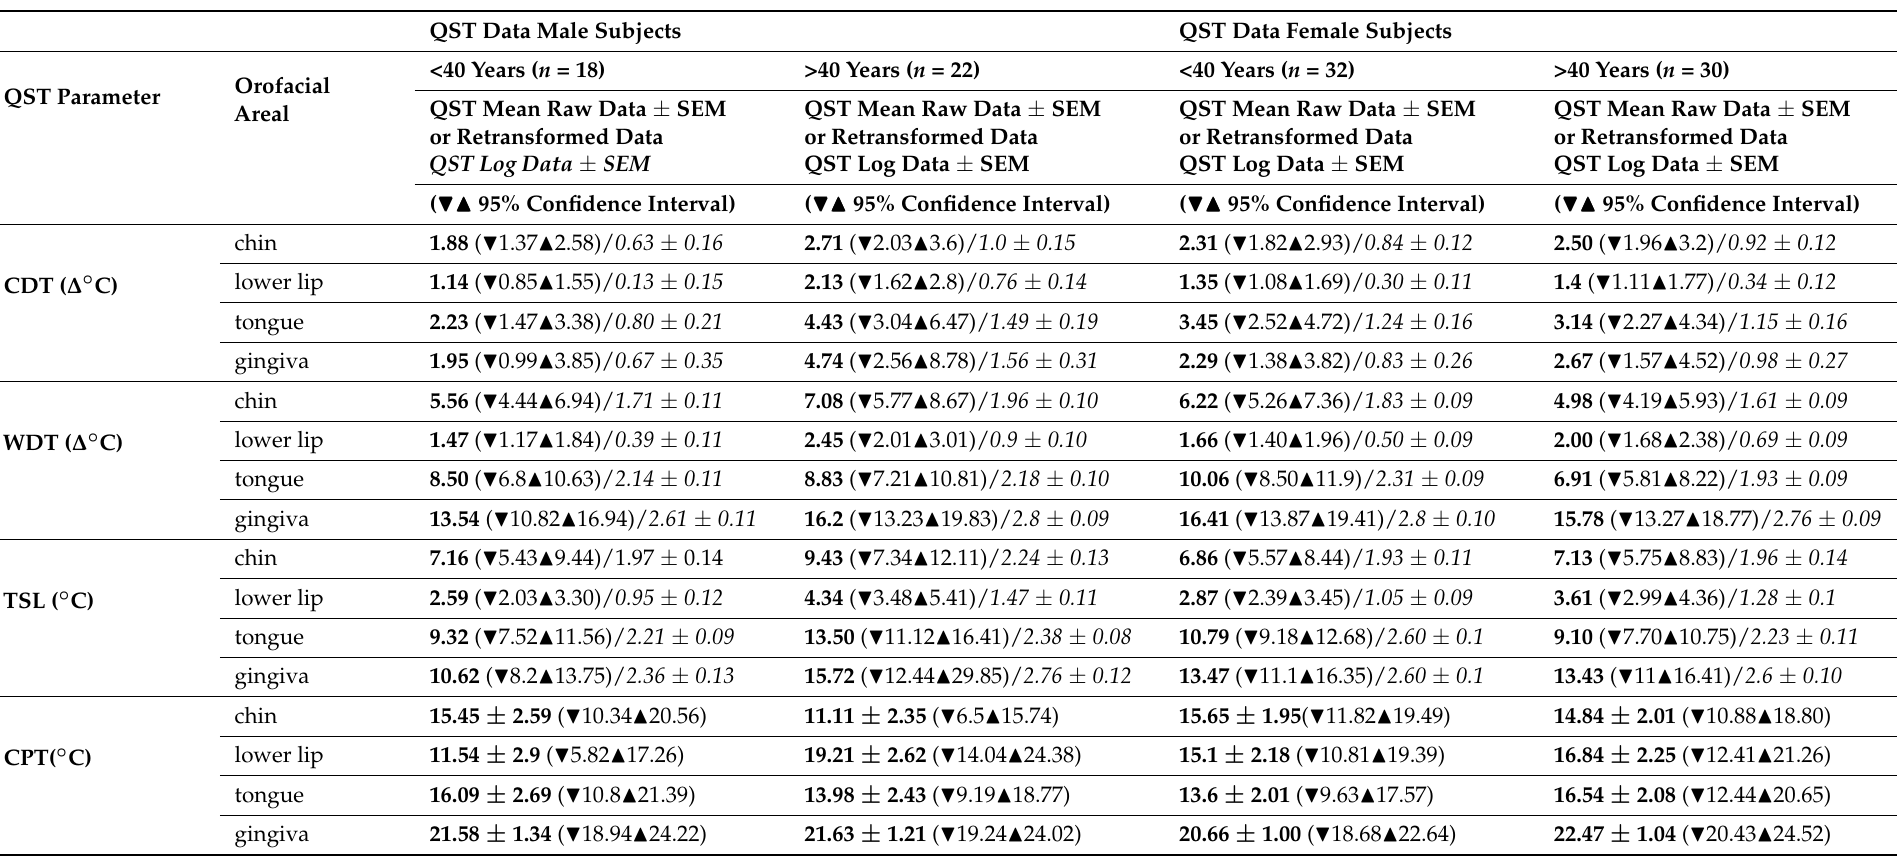
Table 1. Orofacial sensory reference data. Paradoxical heat sensation (PHS) and dynamic mechanical allodynia (DMA) did not significantly occur in healthy subjects. (QST = Quantitative Sensory Testing, CDT = Cold Detection Threshold, CPT = Cold Pain Threshold, WDT = Warm Detection Threshold, HPT = Heat Pain Threshold, MDT = Mechanical Detection Threshold, MPS = Mechanical Pain Sensitivity, MPT = Mechanical Pain Threshold, TSL = Thermal Sensory Limen, WUR = Wind Up Ration, SEM = standard error of the